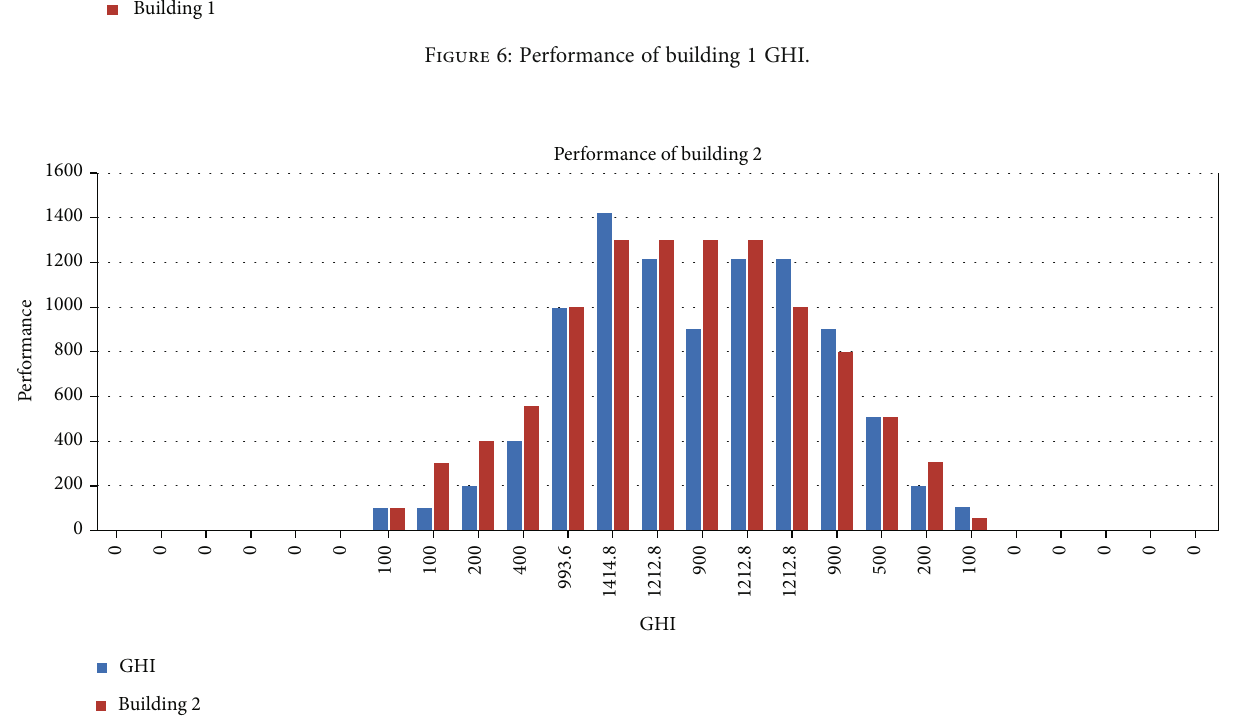
Figure 7: Performance of building 2